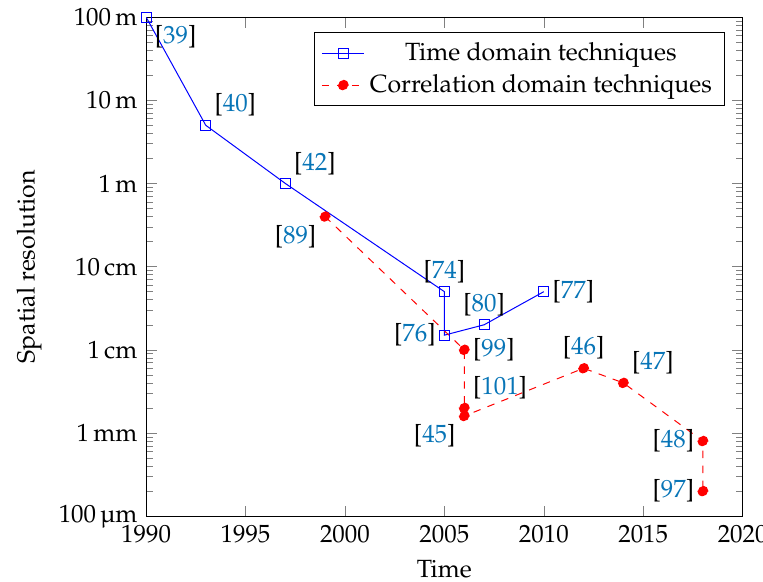
Figure 2. Overview of the spatial resolution evolution the time domain and correlation domain